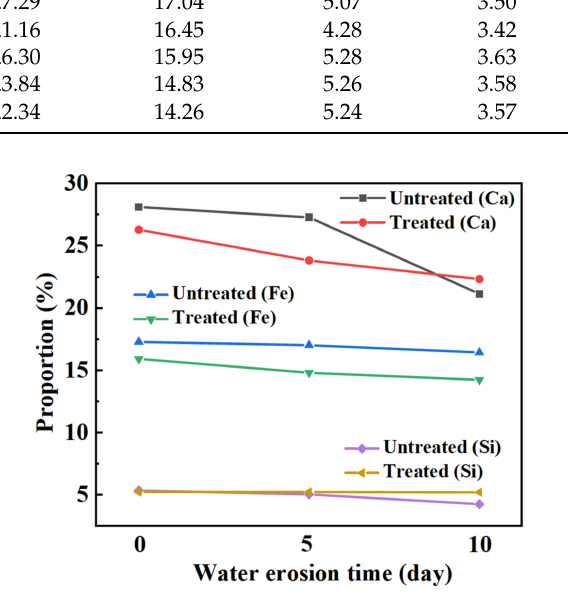
Figure 15. Influence of water erosion on main chemical elements in steel